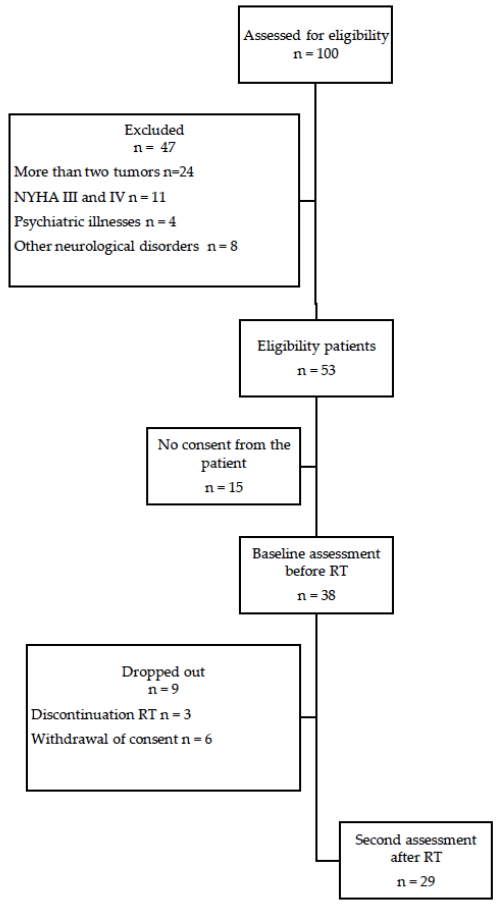
Figure 1. The flow of participants through the study. Table 1. Demographic and clinical characteristics of the study